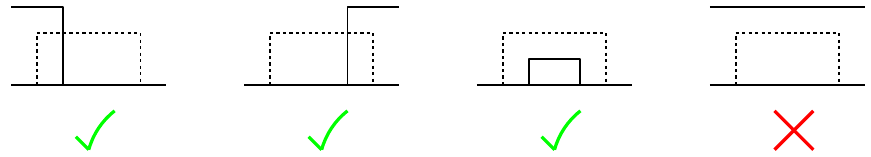
Figure 7. Counting scheme for correlators. The last case is assigned a value of ~ q 2 in our counting, while it should get no ~ q